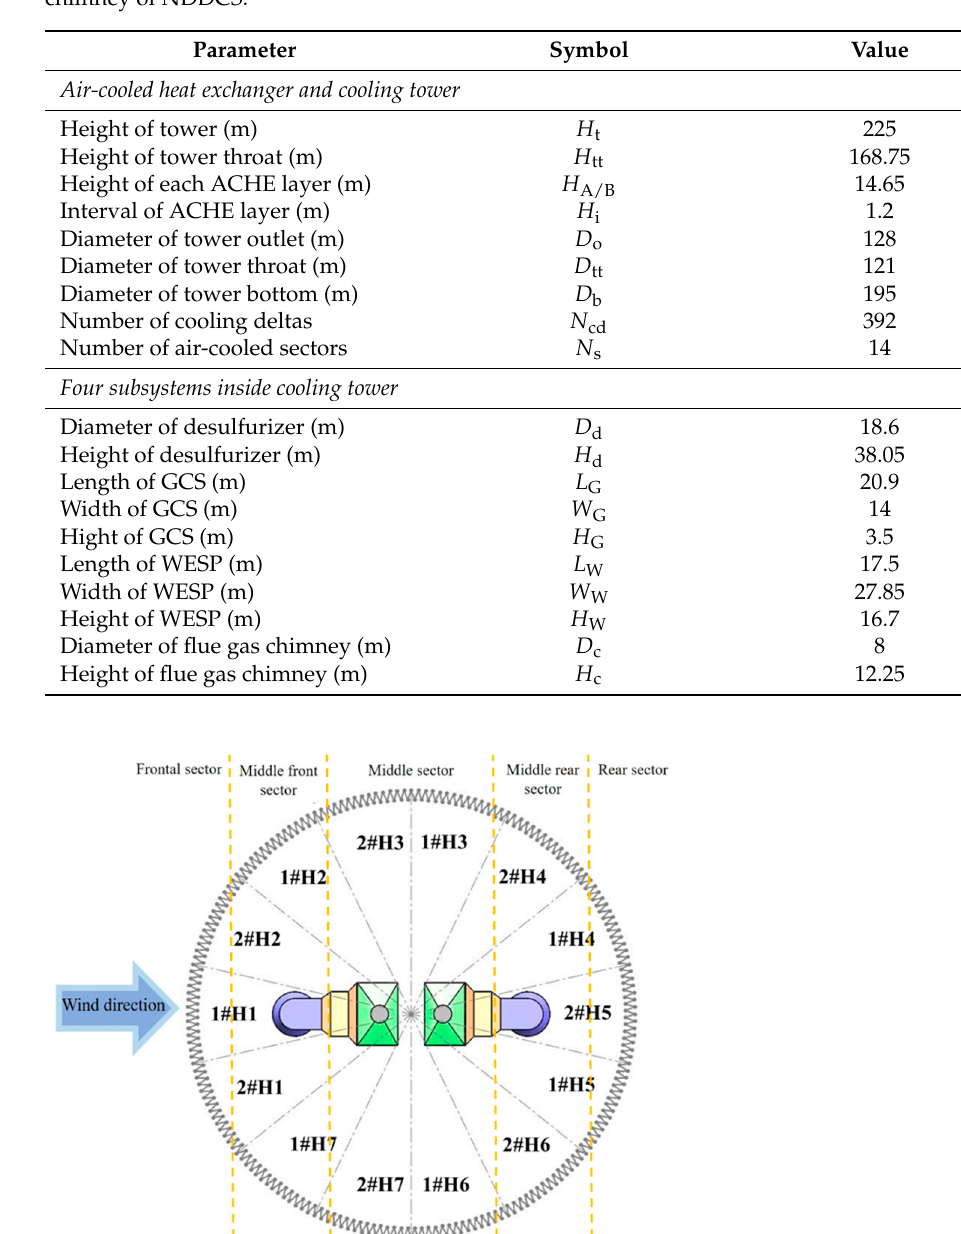
Table 1. Geometric parameters of ACHE, cooling tower, desulfurizer, GCS, WESP, and flue gas chimney of NDDCS.